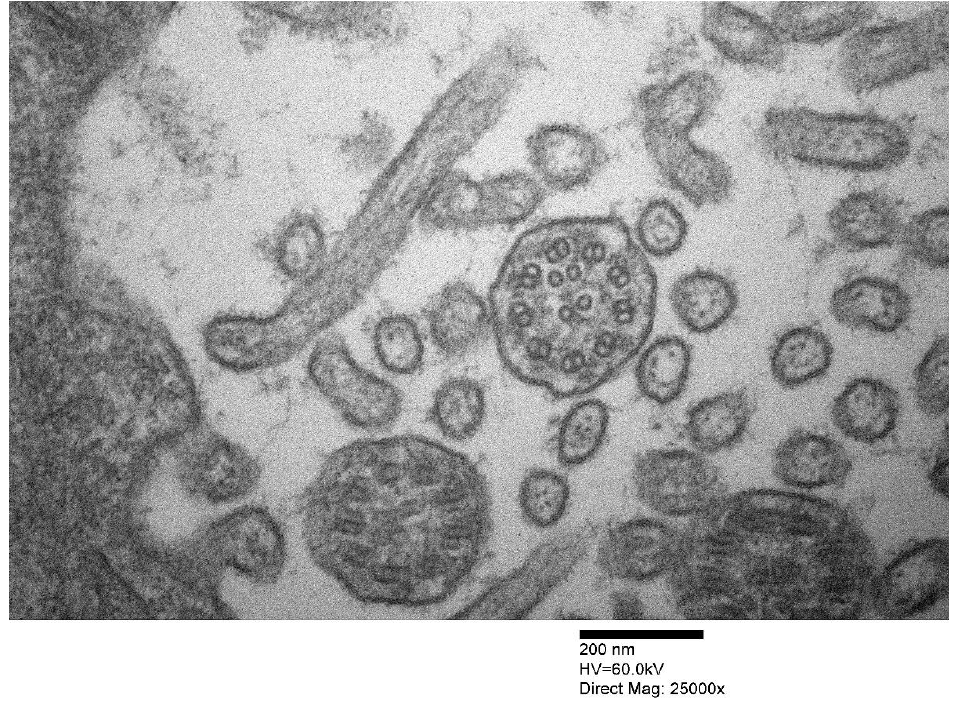
Figure 3. Cilia of a patient with primary ciliary dyskinesia showing microtubular disorganization (transmission electron microscopy, see the bar for details regarding magnification).